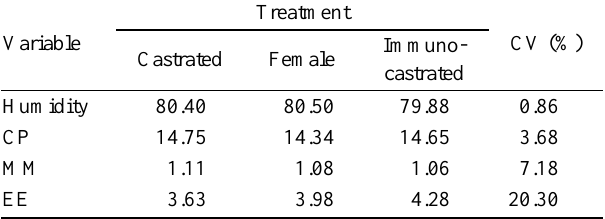
Table 5. Humidity, crude protein (CP), mineral matter (MM) and ether extract (EE) of the meat of male immunocastrated, surgical